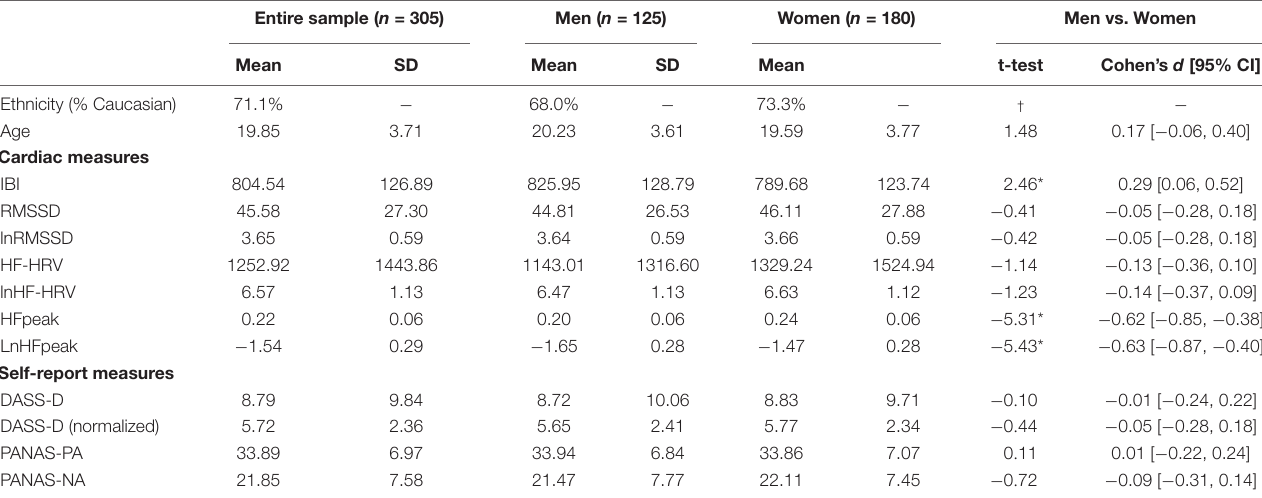
TABLE 1 | Descriptive statistics.